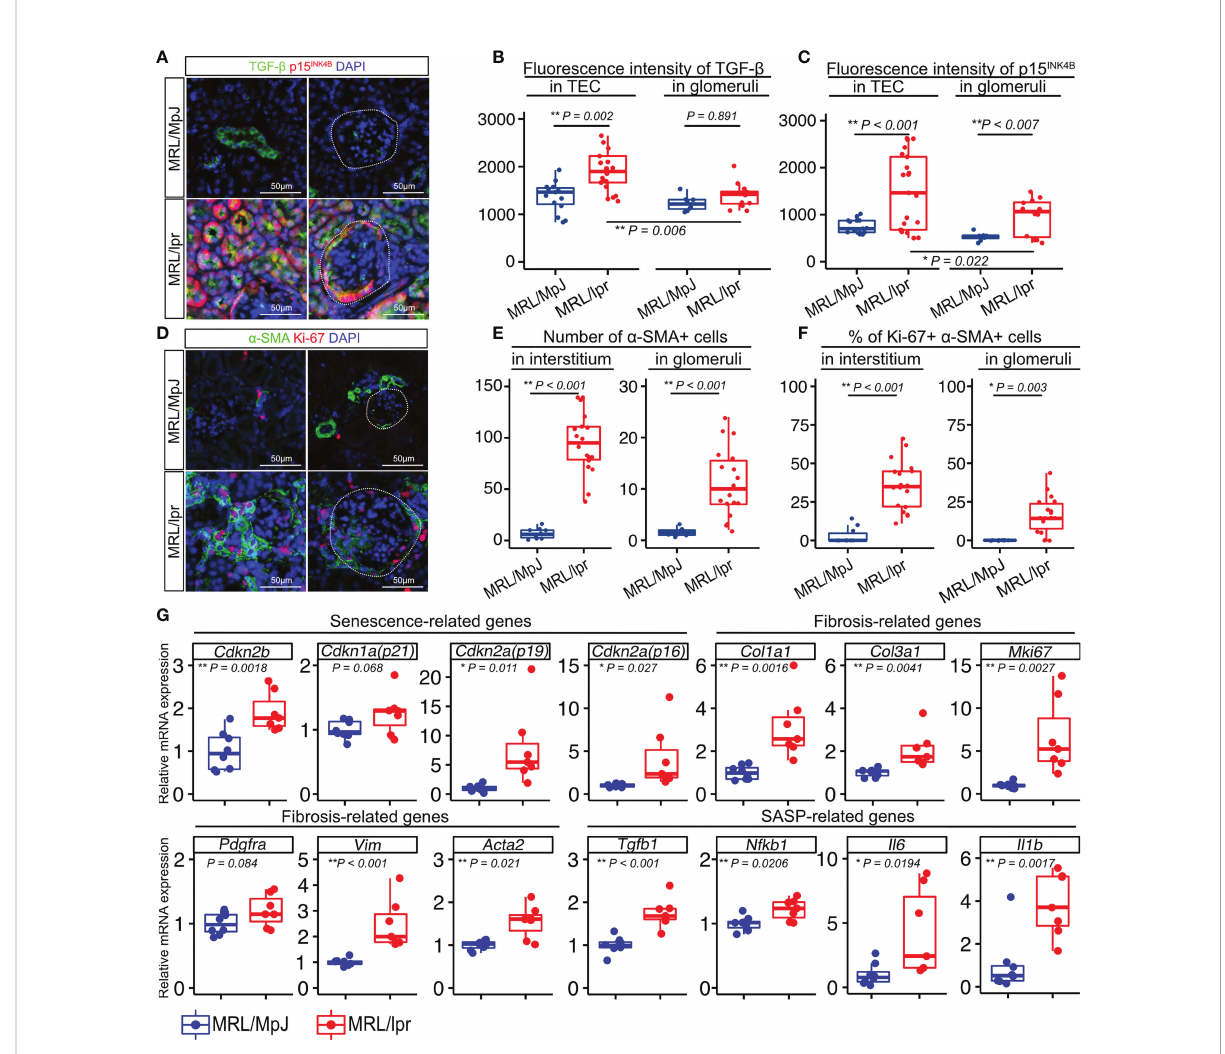
FIGURE 1 Numbers of senescent cells and proliferating cells are increased in the kidneys of MRL/lpr mice. (A) Representative images of immunohistochemical staining for TGF- b 1 and p15 INK4B in kidney sections from MRL/lpr and MRL/MpJ (control) mice. (B – C) Quanti fi cation of TGF- b 1 and p15 INK4B expression levels in tubular epithelial cells (TEC) and glomeruli measured using fl uorescence intensity (arbitrary units, a.u.). (D) Representative images of immunohistochemical staining for a -SMA and Ki-67 in kidney sections from MRL/lpr and MRL/MpJ